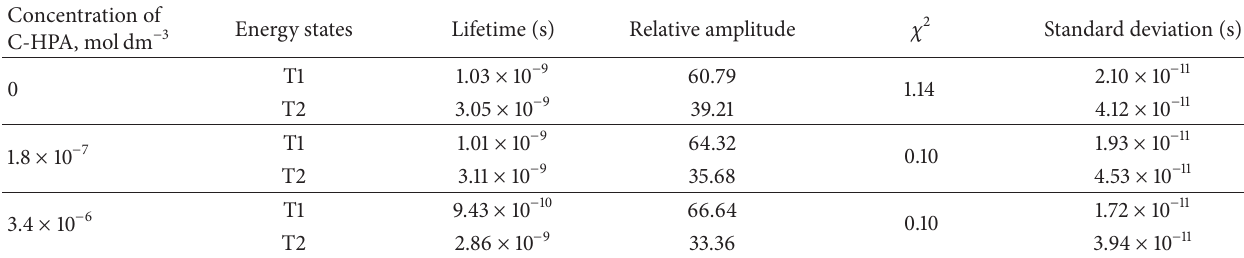
Table 5: Time-resolved fluorescence spectral data of C334 in C-HPA.